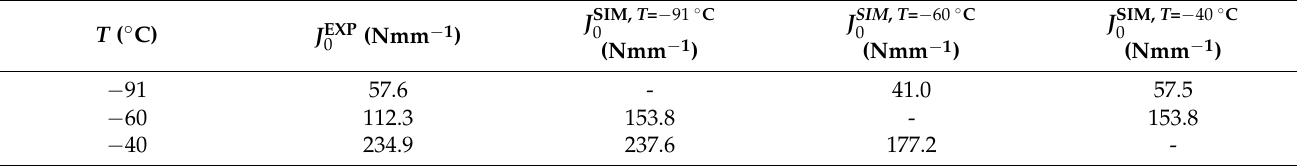
Table 1. Characteristic fracture toughness J 0 calculated based on a Weibull distribution fit to the experimental data using the maximum likelihood method and predicted using the developed method based on the fracture toughness experimental data at T = − 91 ◦ C, − 60 ◦ C and − 40 ◦ C, and a shape parameter m =